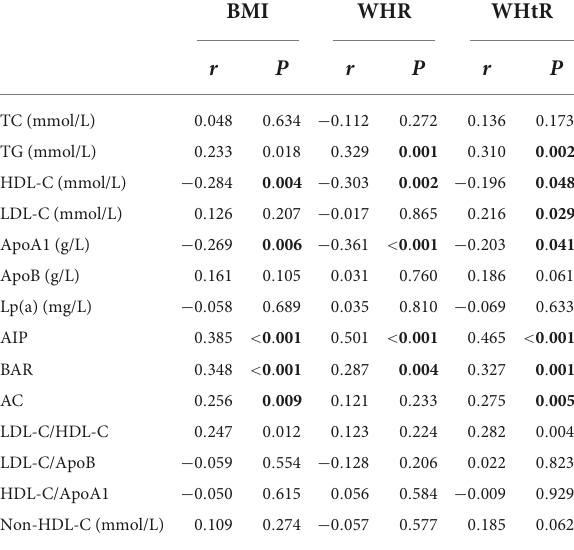
TABLE 2 Correlation analysis of overweight and obesity indicators and lipid parameters in patients with familial